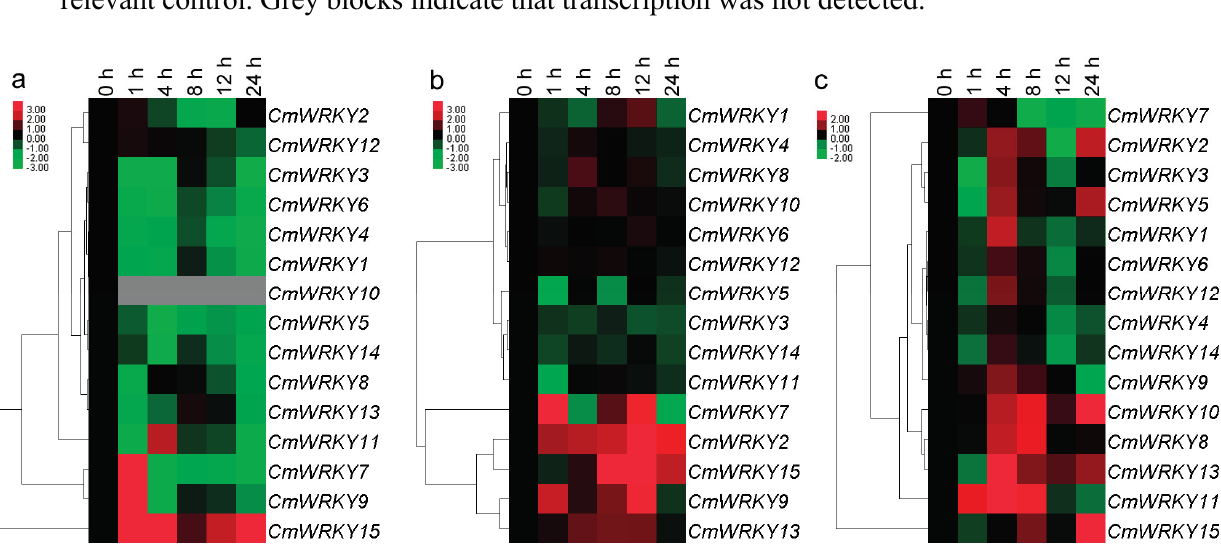
Figure 4. Differential transcription of CmWRKY genes in leaves as induced by the exogenous supply of ( a ) abscisic acid (ABA); ( b ) methyl jasmonate (MeJA) and ( c ) salicylic acid (SA). Green indicates lower and red higher transcript abundance compared to the relevant control. Grey blocks indicate that transcription was not detected.